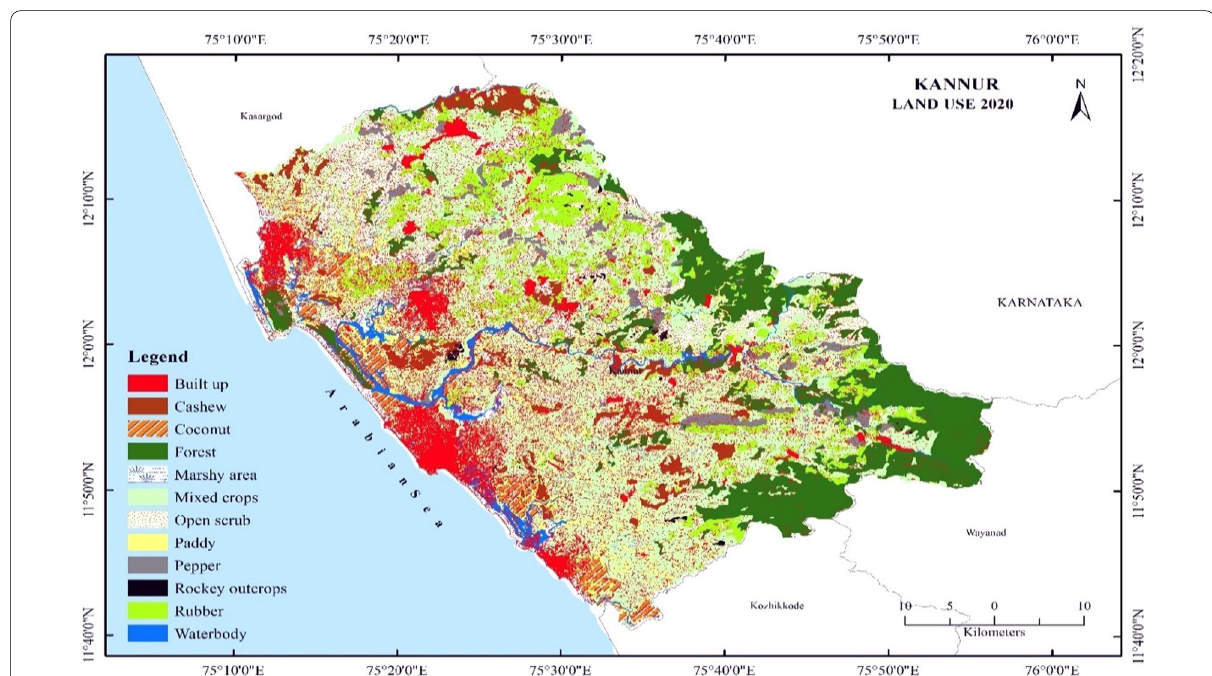
Fig. 2 Land use/land cover classification of